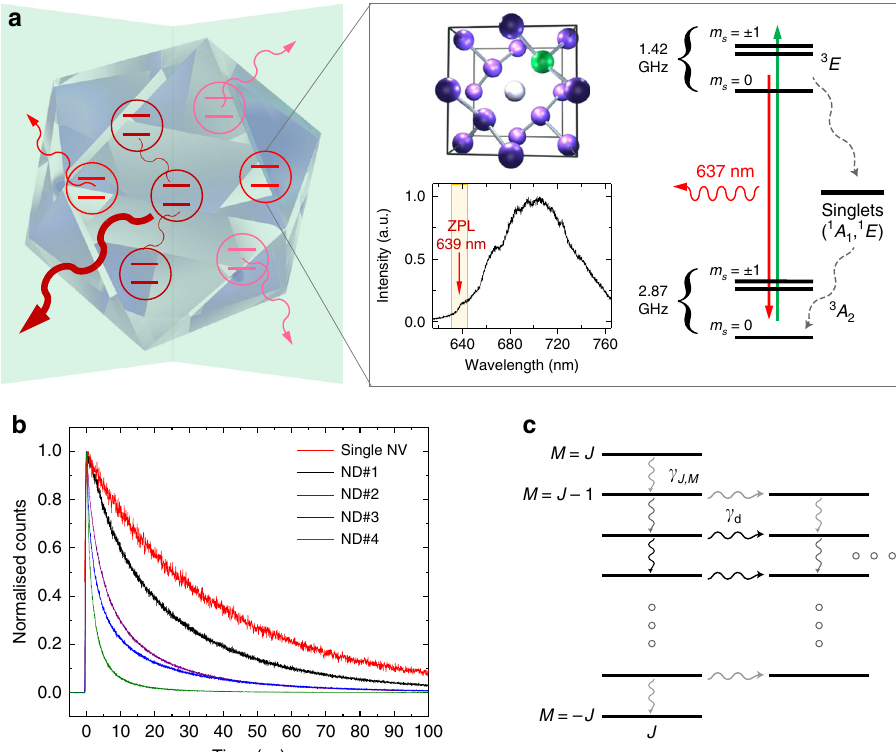
Fig. 1 Superradiance from nanodiamonds with many NV centres. a Graphic representation of cooperatively interacting NV centres emitting a superradiant burst from a nanoscale diamond crystal. The zoom-in shows the underlying crystalline structure around a single NV centre, with the substitutional nitrogen atom indicated in green and the vacancy in white. It also displays the level structure of a single NV centre in bulk diamond 11 . Due to strong vibronic sidebands, only a fraction of photons is emitted into the ZPL. In our high-density NV ND sample the ZPL is shifted from the bulk value of 637 nm, as seen in the representative fl uorescence spectrum with a ZPL of around 639 nm 12 . b Measured normalised fl uorescence decay curves for fi ve different NDs, with lifetimes ranging from the usual few tens of nanoseconds for a single NV centre in a ND (red trace), to around 1 ns for high-density NV NDs (green trace, ND #4). c Illustration of the Dicke ladder of states: Collective optical decay couples descending states within each pseudospin J -subspace at a characteristic rate γ J , M . Local dephasing at rate γ d decouples individual spins from the collective subspace, leaving the remaining spins in a smaller J -subspace. Thicker/darker decay lines denote stronger decay rates with maximum decay near M = 0